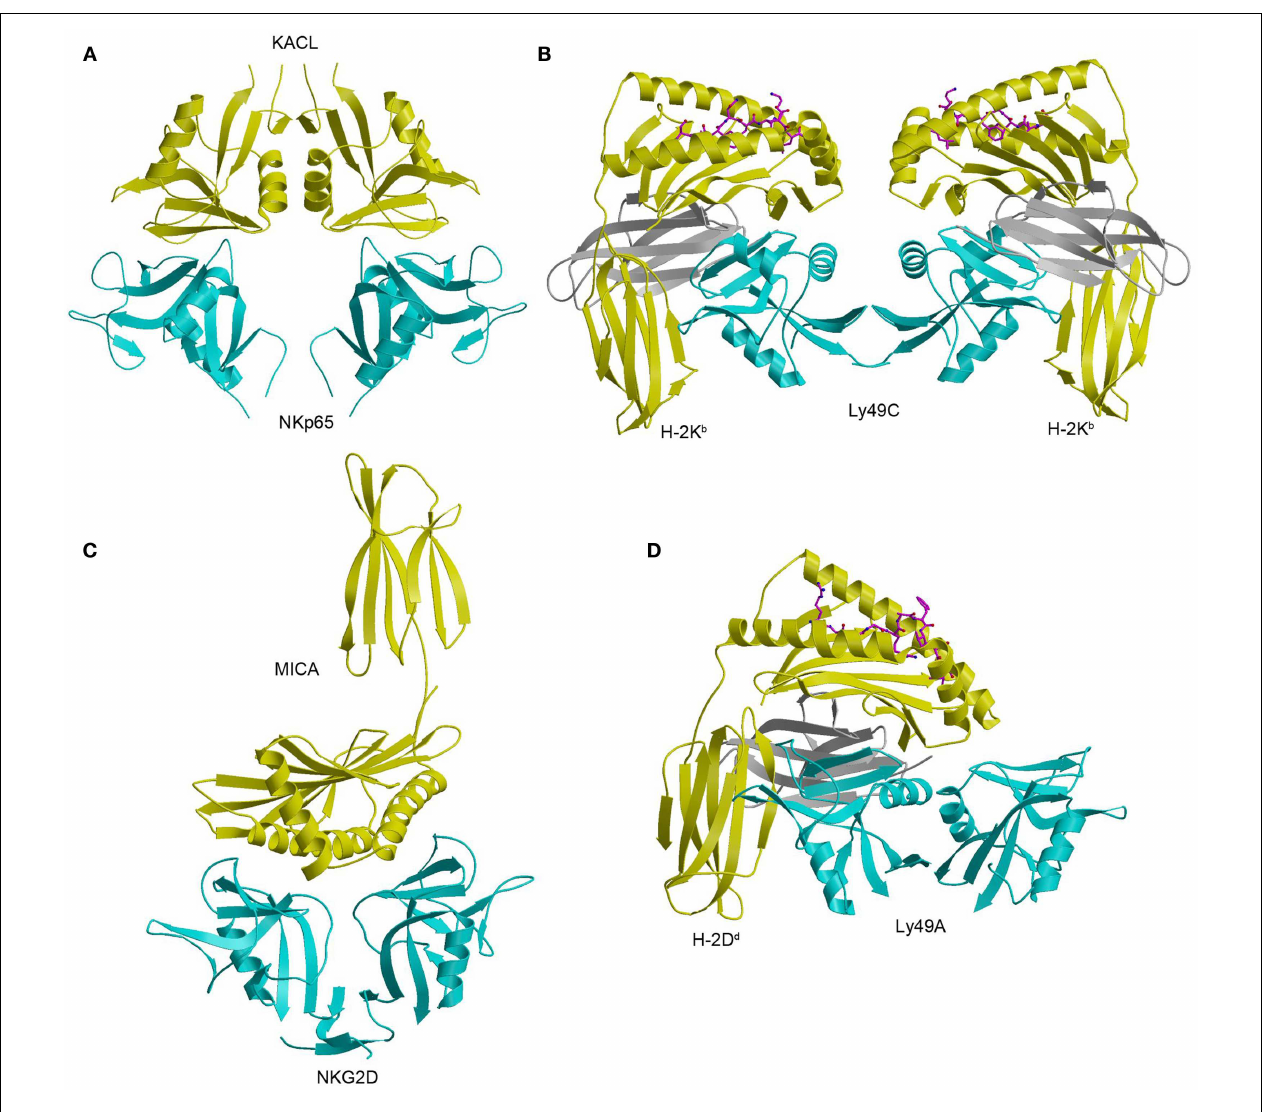
the H-2K b heavy chain is yellow, and β 2 m is gray. (C) Structure of the NKG2D–MICA complex (1HYR).The NKG2D dimer is cyan and MICA is yellow. (D) Structure of the Ly49A–H-2D d complex (1QO3).The Ly49A dimer is cyan, the H-2D d is heavy chain is yellow, and β 2 m is